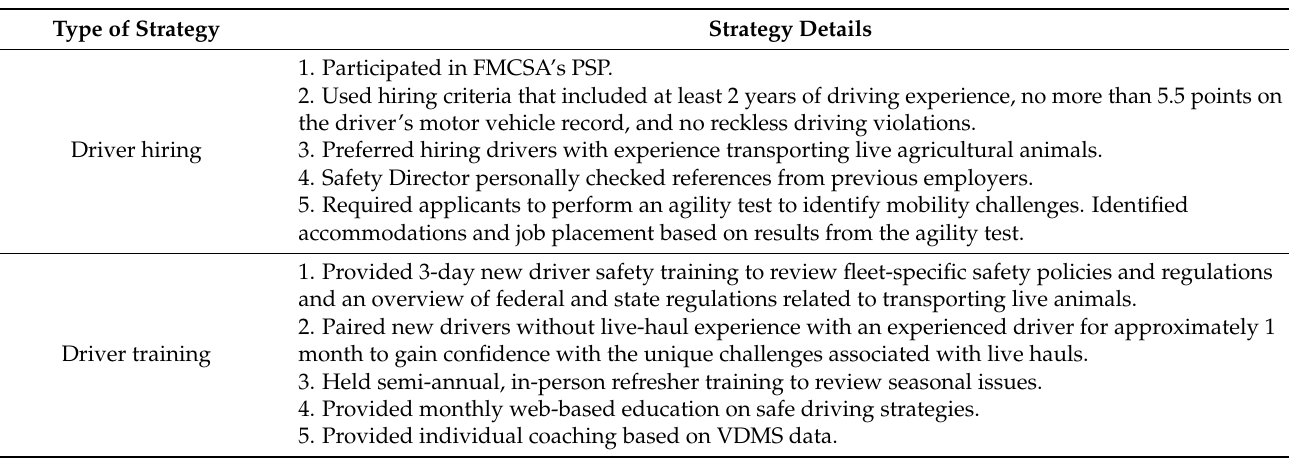
Table 9. Fleet G’s safety improvement